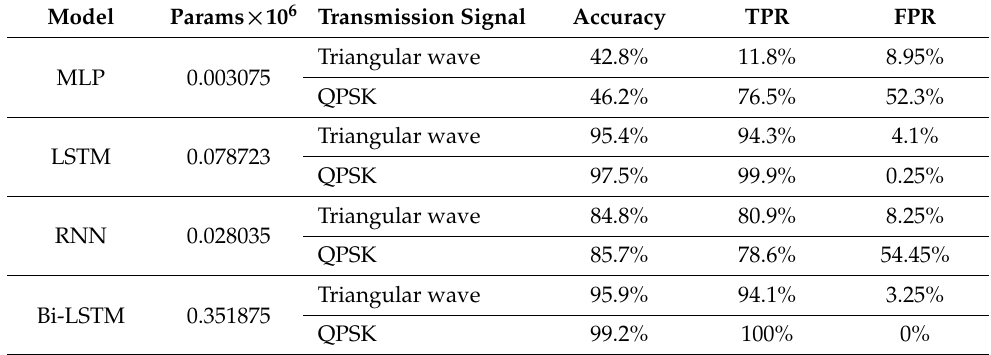
Table 2. Comparison between different methods.